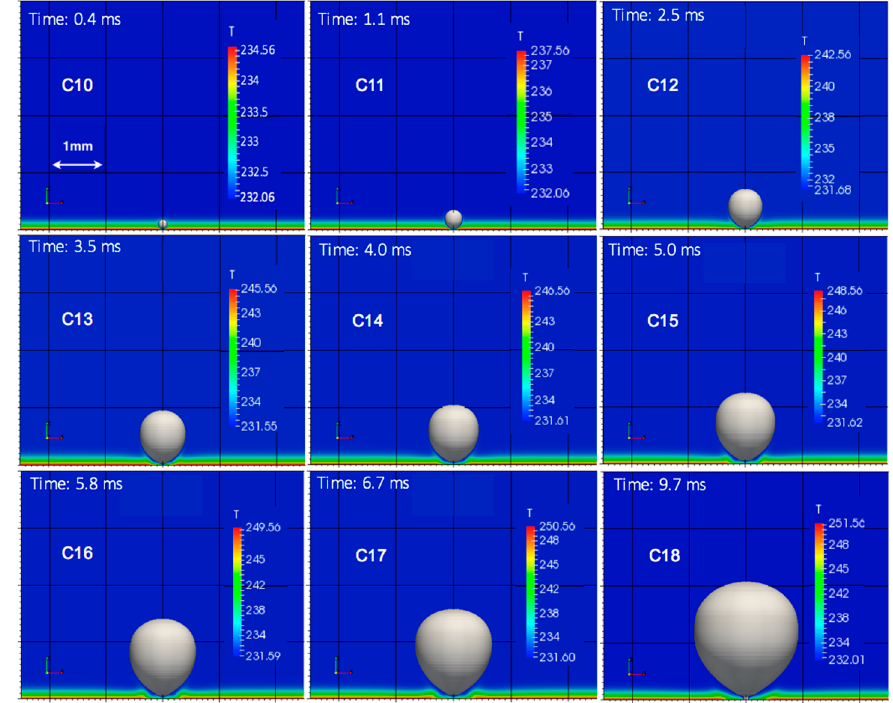
Figure 21. Spatial evolution of generated bubble at the time of detachment for each R22 case of the Series C parametric numerical simulations. Energies 2017 , 10 , 272